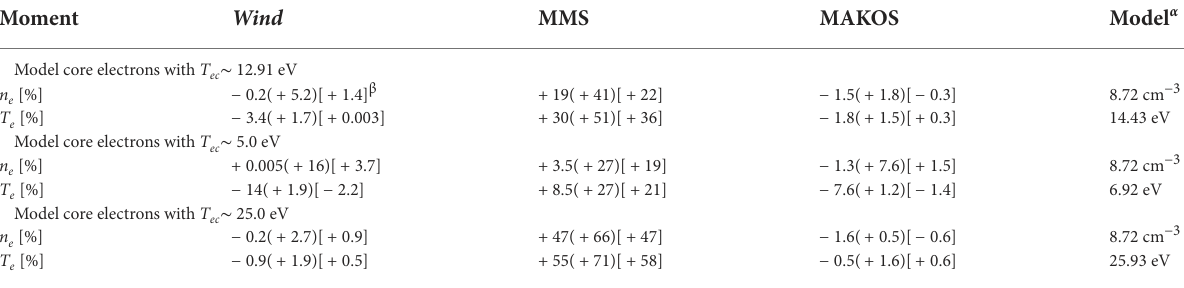
TABLE 2 Electronvelocitymomentaccuracy. Moment Wind MMS Model α